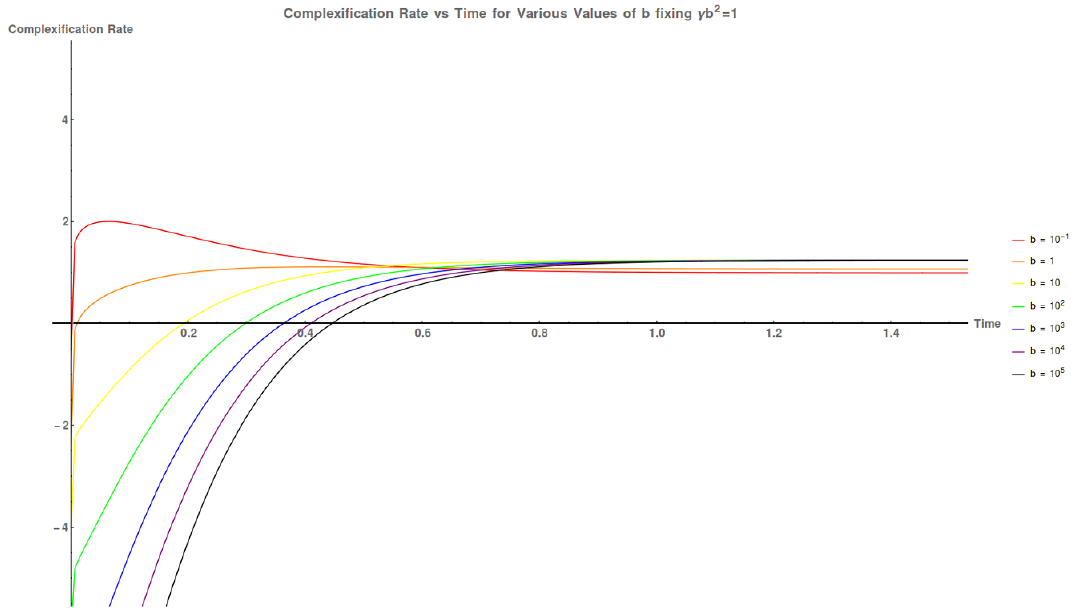
Figure 7 . Normalized complexi(cid:12)cation rate versus time in thermal units. (cid:13)b 2 is held (cid:12)xed at 1 while b = ar H is